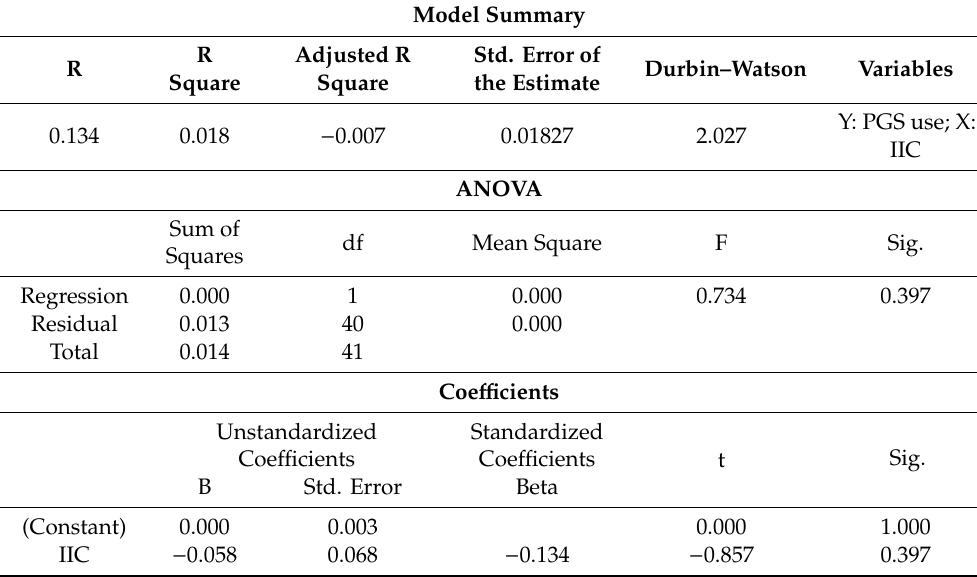
Table 3. Detailed analysis results of Model 1. Model Summary